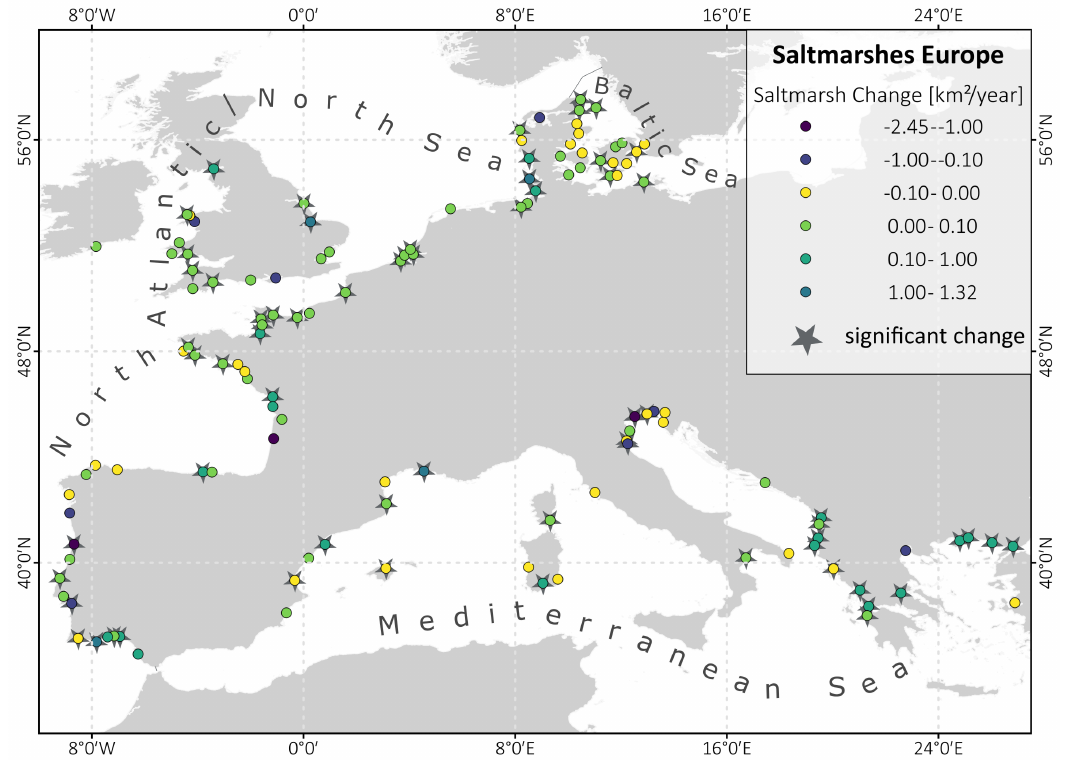
Figure A2. Map of European saltmarshes showing annual absolute (km 2 /year) change in the seaward extent of saltmarshes and whether or not the detected trends between 1986 and 2010 are significant.